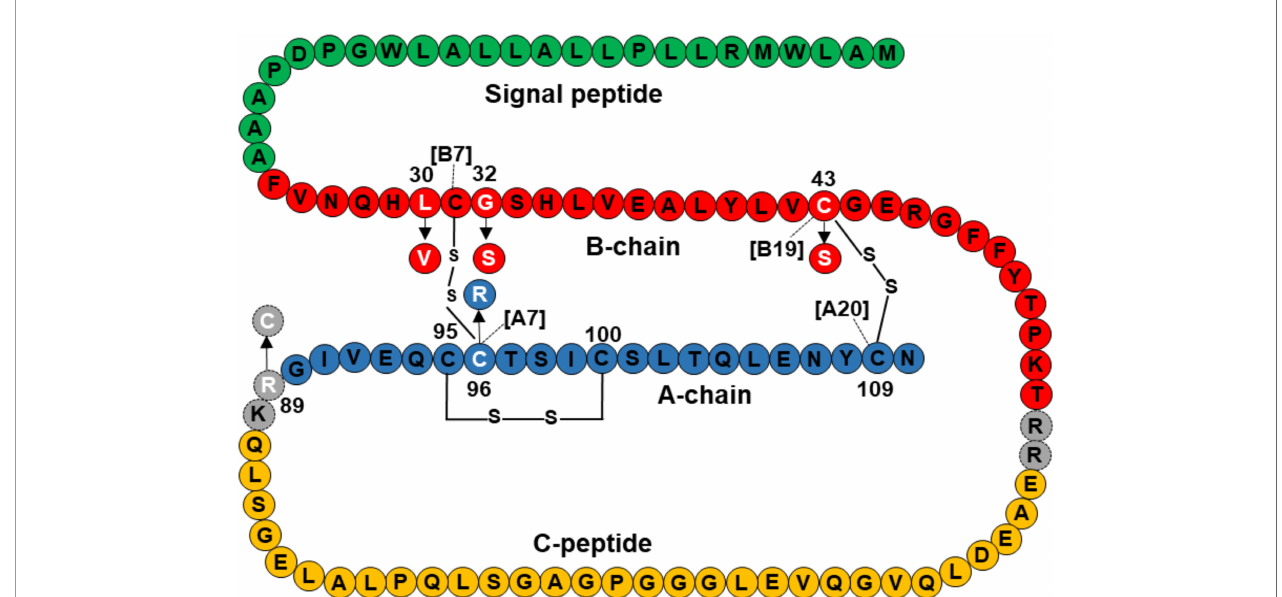
FIGURE 2 | Location of INS mutations identi fi ed in 10 Vietnamese patients in the preproinsulin. Green, red, orange, and blue color amino acids represent for signal peptide, B-chain, C-peptide, and A-chain, respectively. Mutations are marked in white, including L30V, G32S, C43S, R89C, and C96R. Amino acid sequence of preproinsulin was adapted from Støy et al. (15).